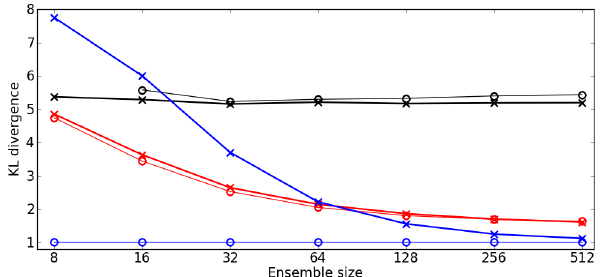
Figure 11. Time-averaged Kullback–Leibler divergence on the X variable for the EnKF (thick black line with crosses), the RHF (thin black line with open circles), the SIR particle filter (thick blue line with crosses), the full MRHF (thick red line with crosses), and the mean-field approximated MRHF (thin red line with open circles); for the experiment on Lorenz 63 when only the third variable ( Z ) is observed every 40 time steps during 10 5 analysis cycles. The thin blue line with open circles represents the time- averaged Kullback–Leibler divergence for the SIR particle filter with 2048 particles, which can be considered as a target